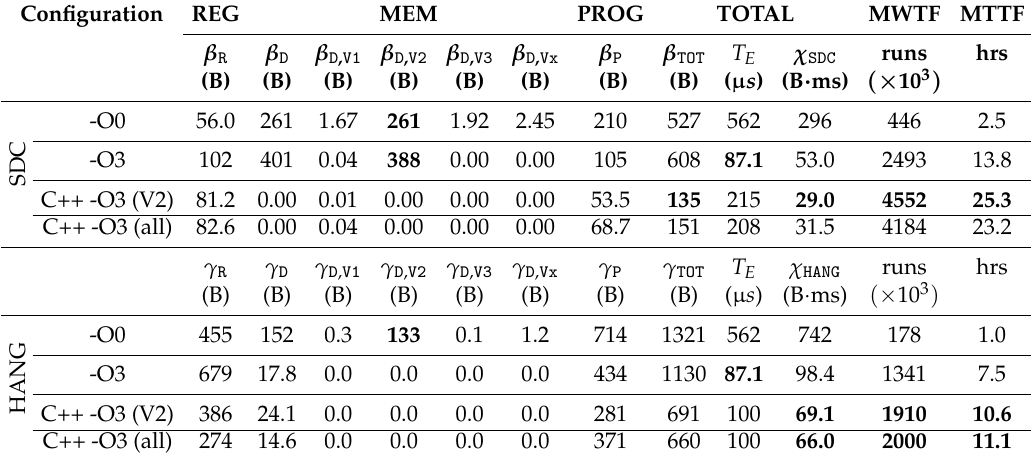
Table 7. Equivalent sizes ( β TOT and γ TOT ), size-time figures ( χ SDC and χ HANG ) and reliability metrics (MWTF and MTTF) of a selected program (optimized BubbleSort) in a few different configuration. The individual impact of Registers (R), total data memory (D), individual memory variables (V1 through V3), other variables (V4), code area (P) and total (TOT), for an ARM Cortex A9 processor, with on-chip memory (OCM) tuning at 666MHz clock frequency. The last two columns refer to the estimated proton irradiation results with radiation flux of 5.45 × 10 5 particles/cm 2 /s and sample time T S = 20 ms . Highlighted values are those referenced in the text for the sake of clarity.